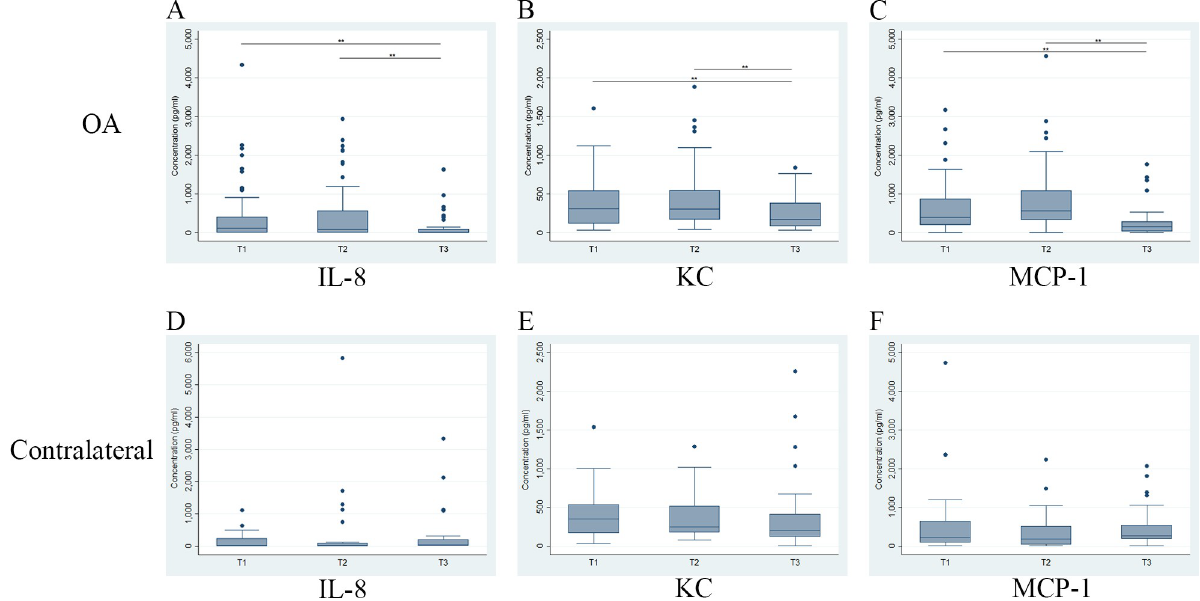
Fig 3. Comparison of temporal changes of concentrations of synovial fluid IL-8, KC and MCP-1 biomarkers for the OA group dogs. The first row of graphs are for synovial fluid samples from index stifles (OA) and the second row are for synovial fluid samples from the stable stifles of dogs in the OA group (contralateral). The time points evaluated are initial visit (T1), 4-week recheck (T2) and 12-week recheck (T3). The horizontal line inside each box is the median and the upper and lower edges of box present the inter-quartile range (IQR). The whiskers are either 1.5 × IQR or the range, whichever is smaller. Dots outside the fence are outliers. � if P < 0.05; �� if P <